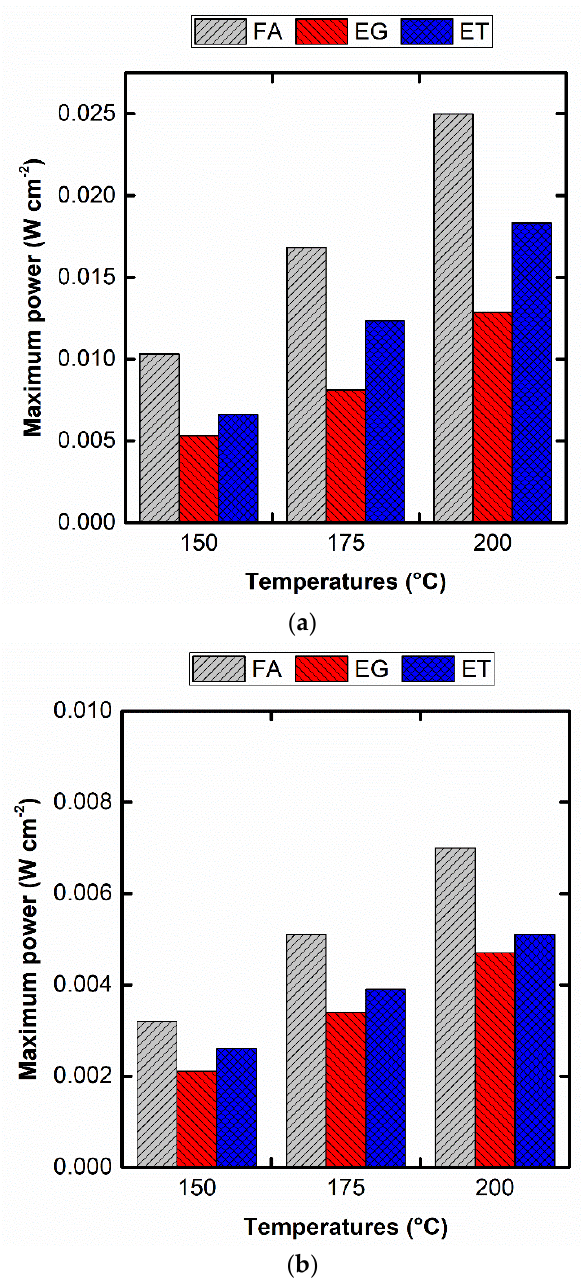
Figure 5. Maximum power densities at the different temperatures for the three used reducing agents, FA120200, EG160200, and ET120300 for: ( a ) DFAFC and ( b ) DEFC.